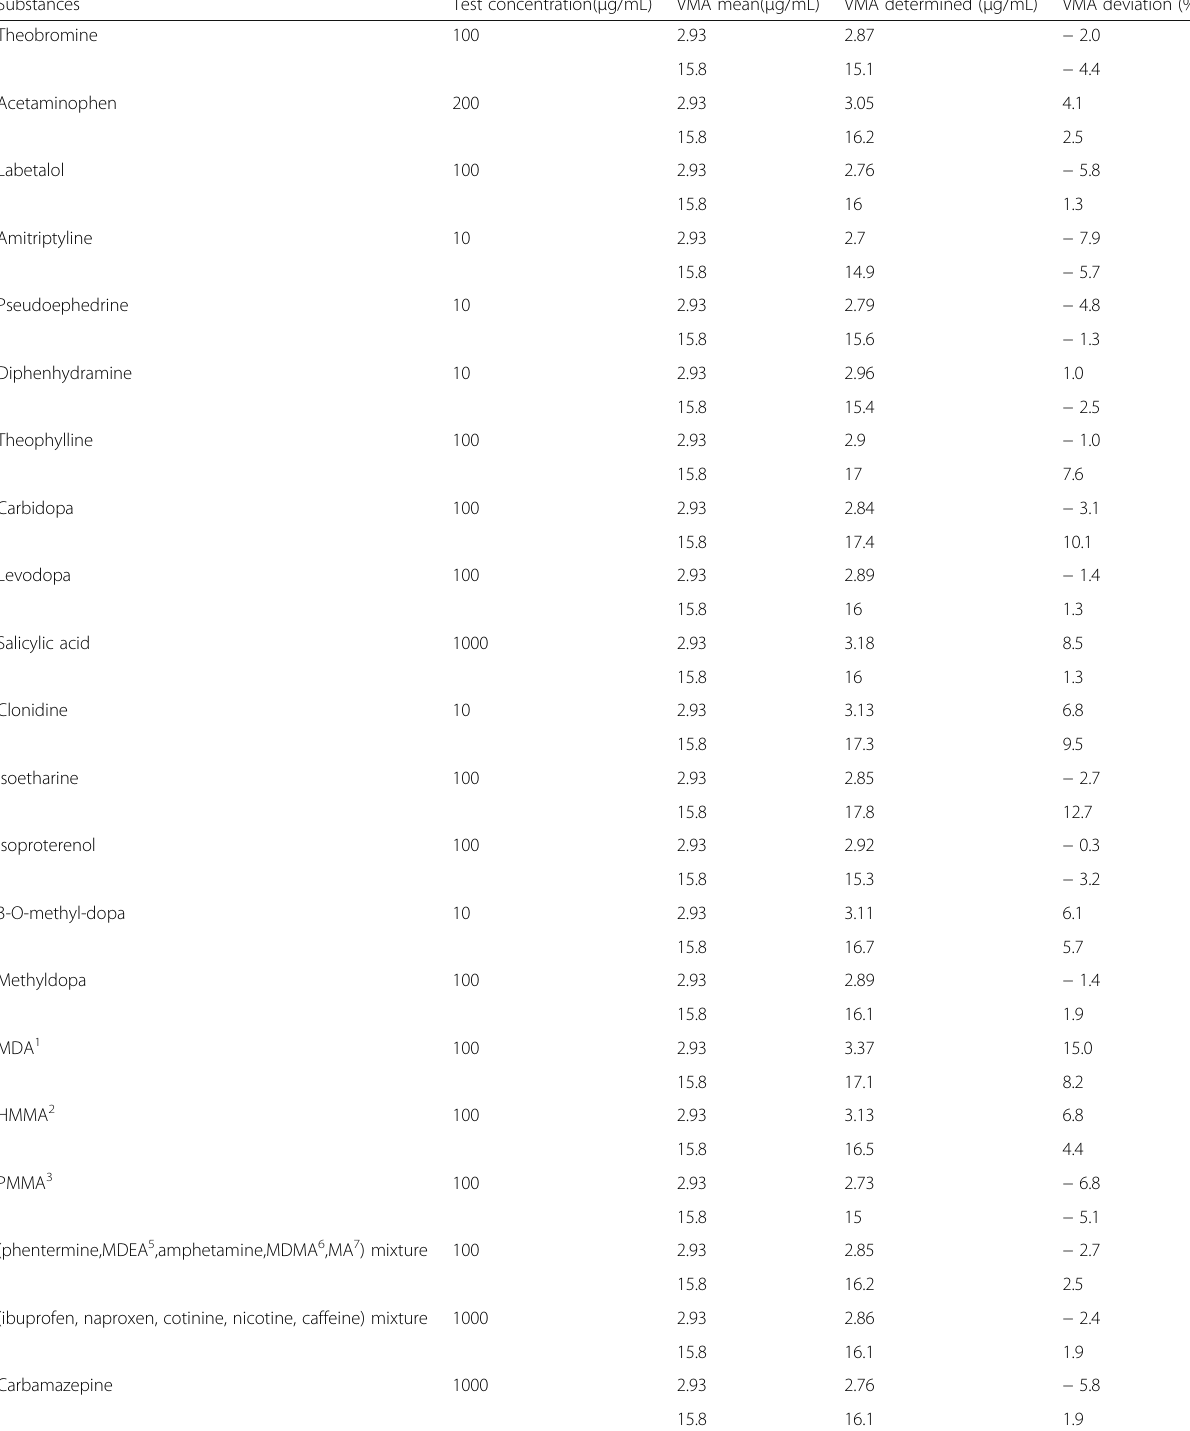
Table 2 Deviations from baseline concentrations of VMA for exogenous potential interferences